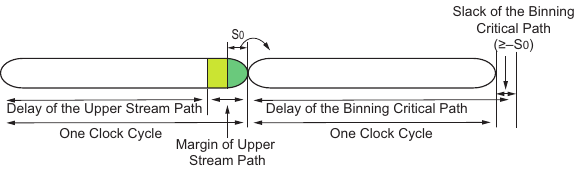
Figure 4. Binning Adaptor borrows unused timing margin from the upper stream path to an adaptable Binning Critical Path